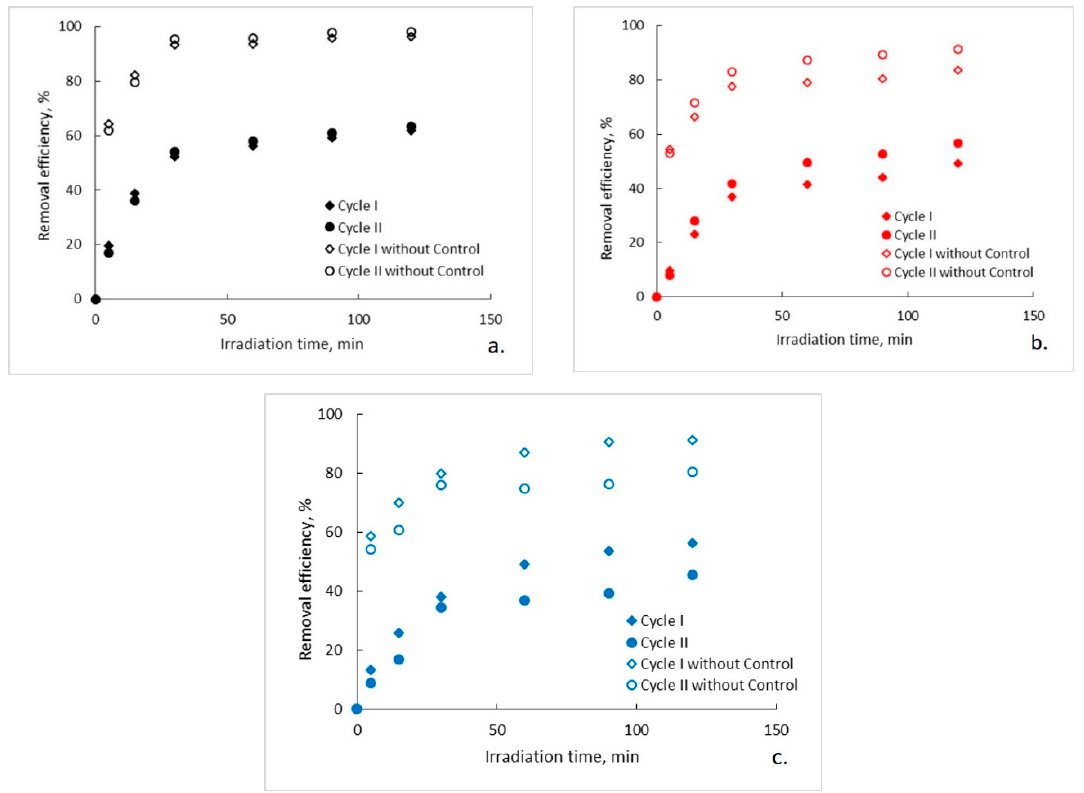
Figure 2. Photocatalytic degradation of ampicillin: ( a ) fiberglass fabric plain woven-type membrane (EWR); ( b ) fiberglass mat-type membrane (EMC); ( c ) fiberglass fabric one fold edge-type membrane (TEX). Error bars represent the calculated standard deviation for the experimental data. Cycle I— green error bars; Cycle II—orange error bars; Control—purple error bars.